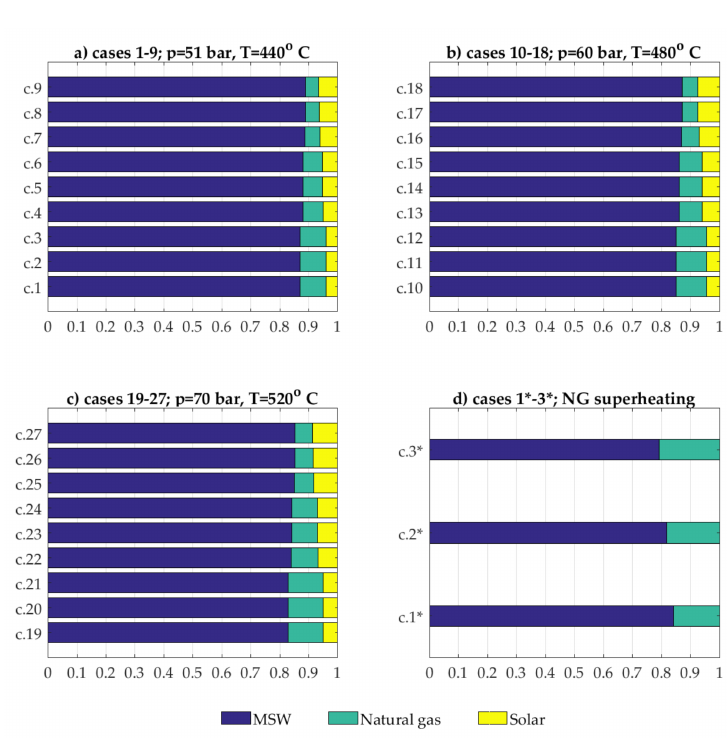
Figure 5. Structure of the electricity production in the analyzed cases ( a – d ).